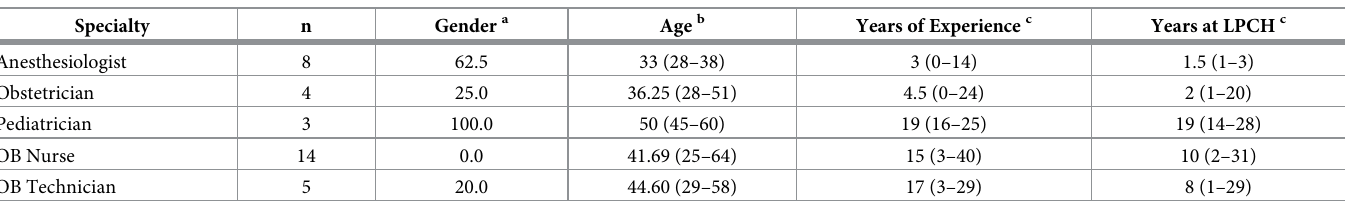
Table 1. Demographic information by specialty.